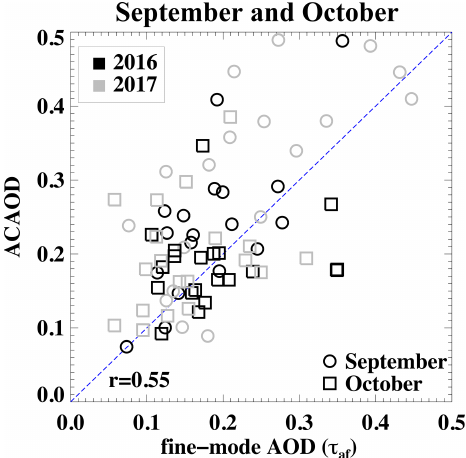
Figure 2. MODIS–Meyer ACAOD versus MODIS fine-mode AOD ( τ af ), for September and October, using 3 ◦ by 3 ◦ domain